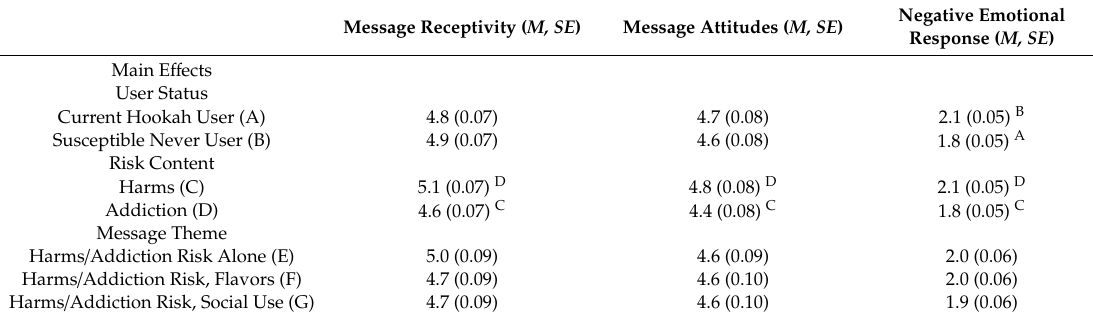
Table 4. Least squares mean di ff erences for main e ff ects for message